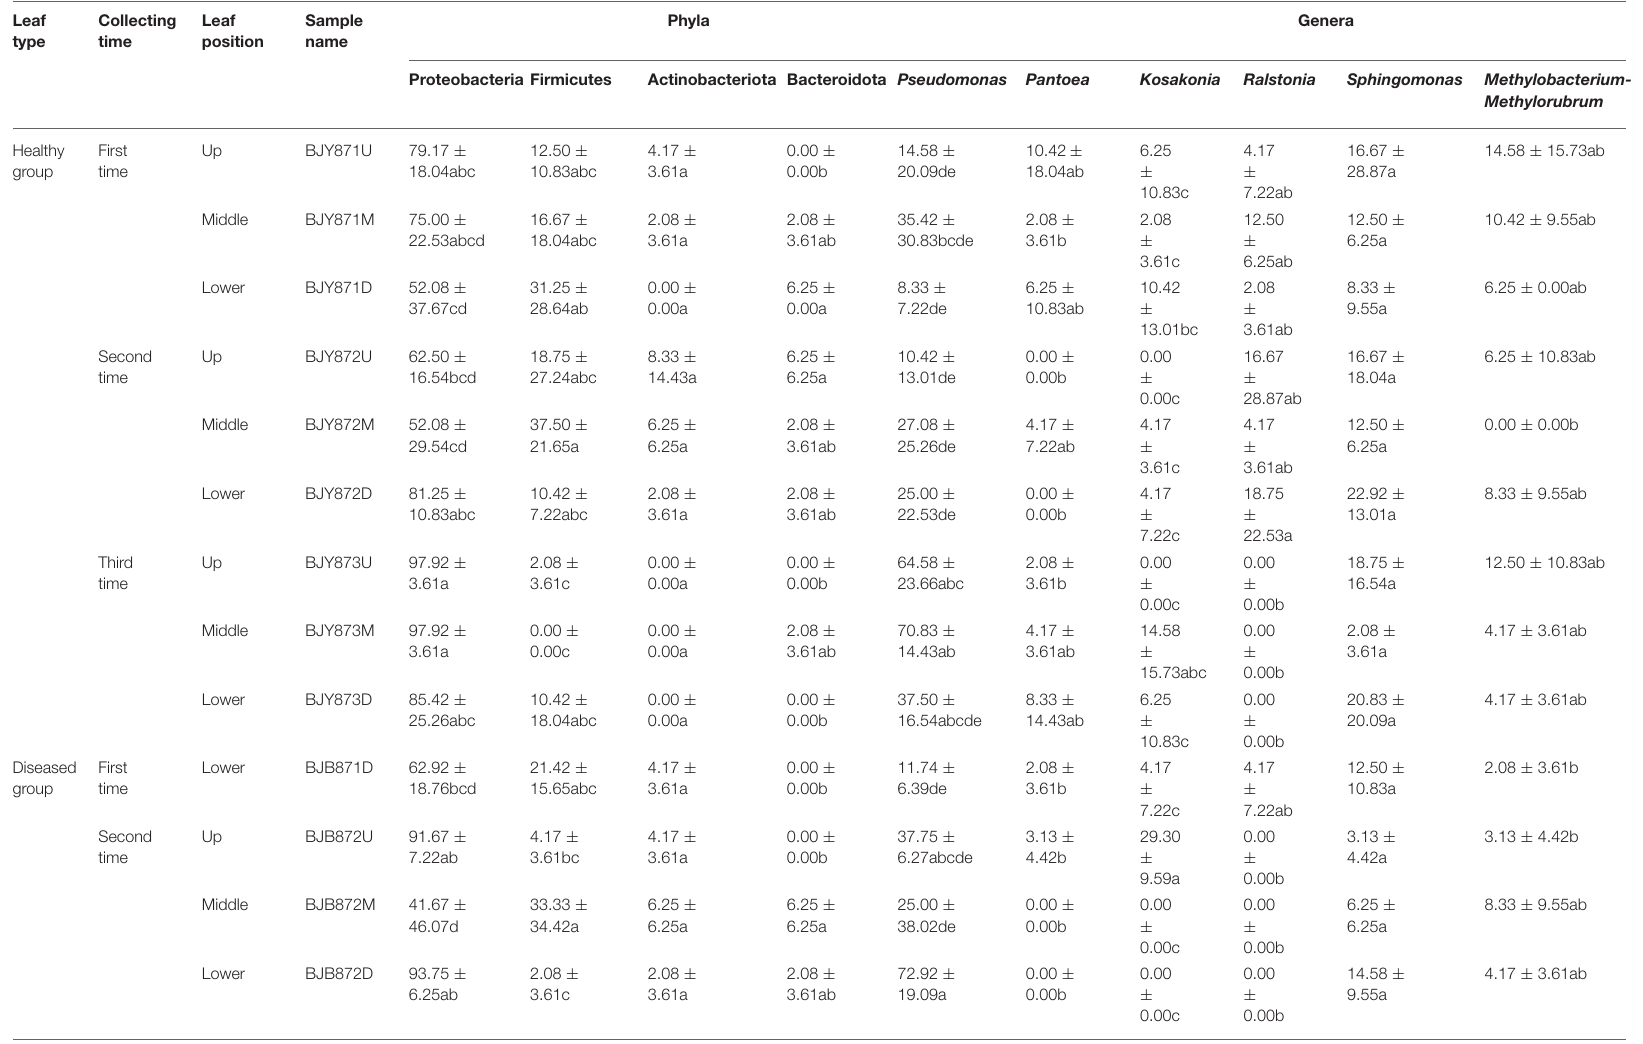
TABLE 4 | Community compositions and relative abundance of phyllosphere microorganism from tobacco leaves infected by Alternaria alternata at bacterial phyla and genera levels